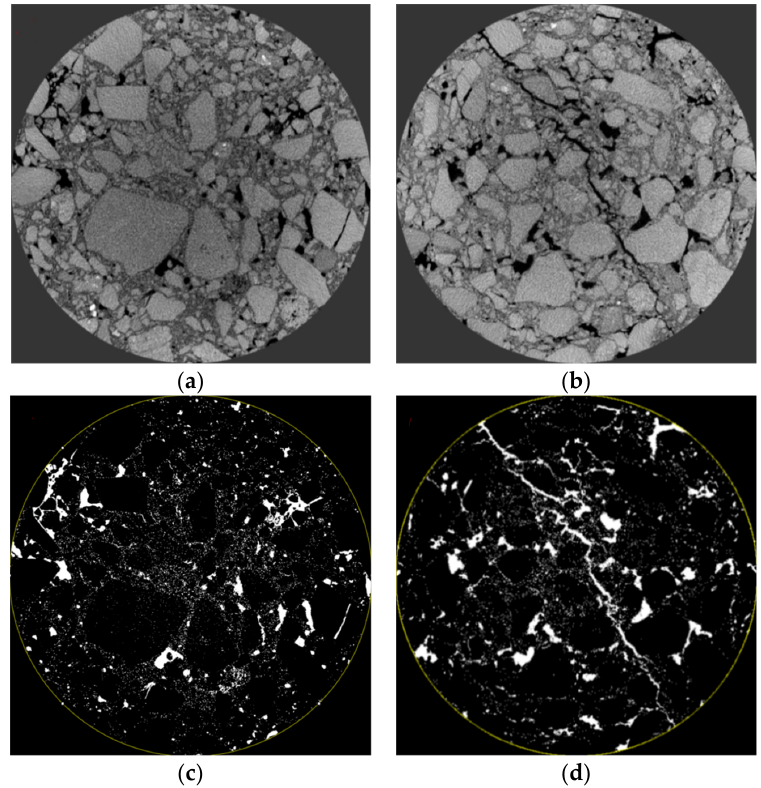
Figure 16. Distribution of void and crack before and after upper splitting of specimen. ( a ) Section image before destruction. ( b ) Section image after destruction. ( c ) Images of voids and cracks before failure. ( d ) Images of voids and cracks after failure.